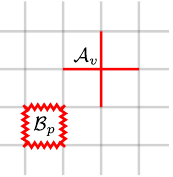
Figure 4: A graphical representation of the two types terms appearing in the toric code Hamiltonian [ Eq. (14) ] . We use a red cross to represent a product of four Z operators on the edges around a vertex and a red zig-zag to represent a product of four X operators around a